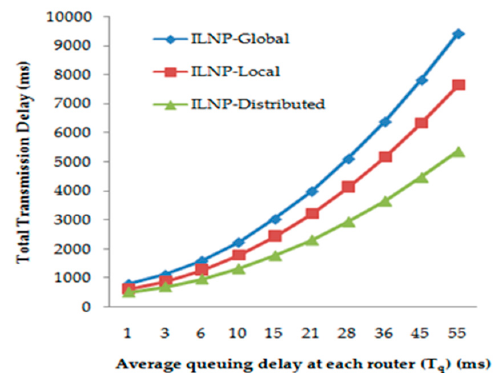
Figure 20. Impact of q on TTD.